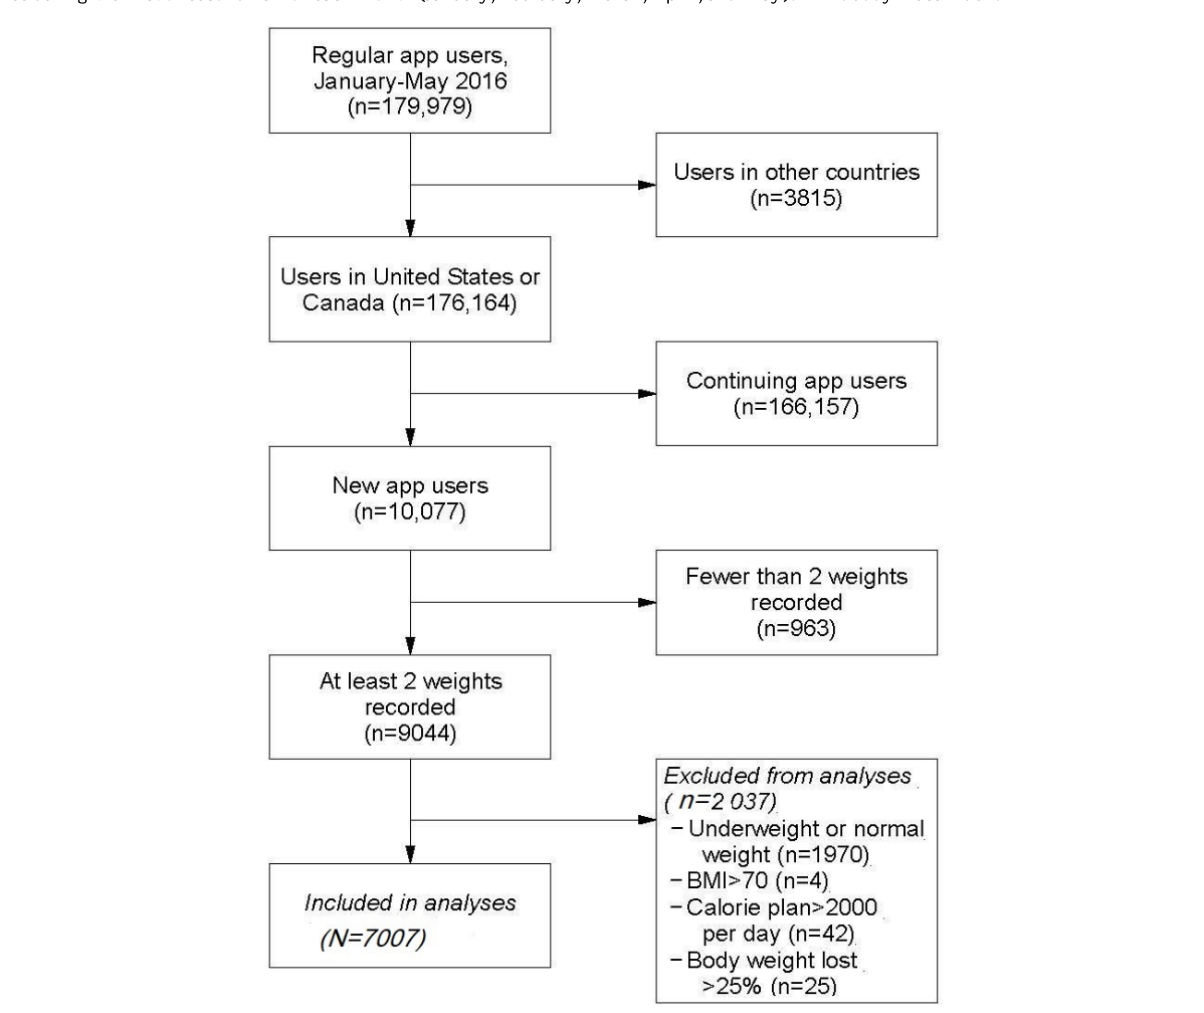
Figure 1. Inclusion of regular Lose It! app users between 18 and 80 years of age in analyses. Regular users are defined as users logging food at least 8 times during the first or second half of each month (January, February, March, April, and May). BMI: body mass